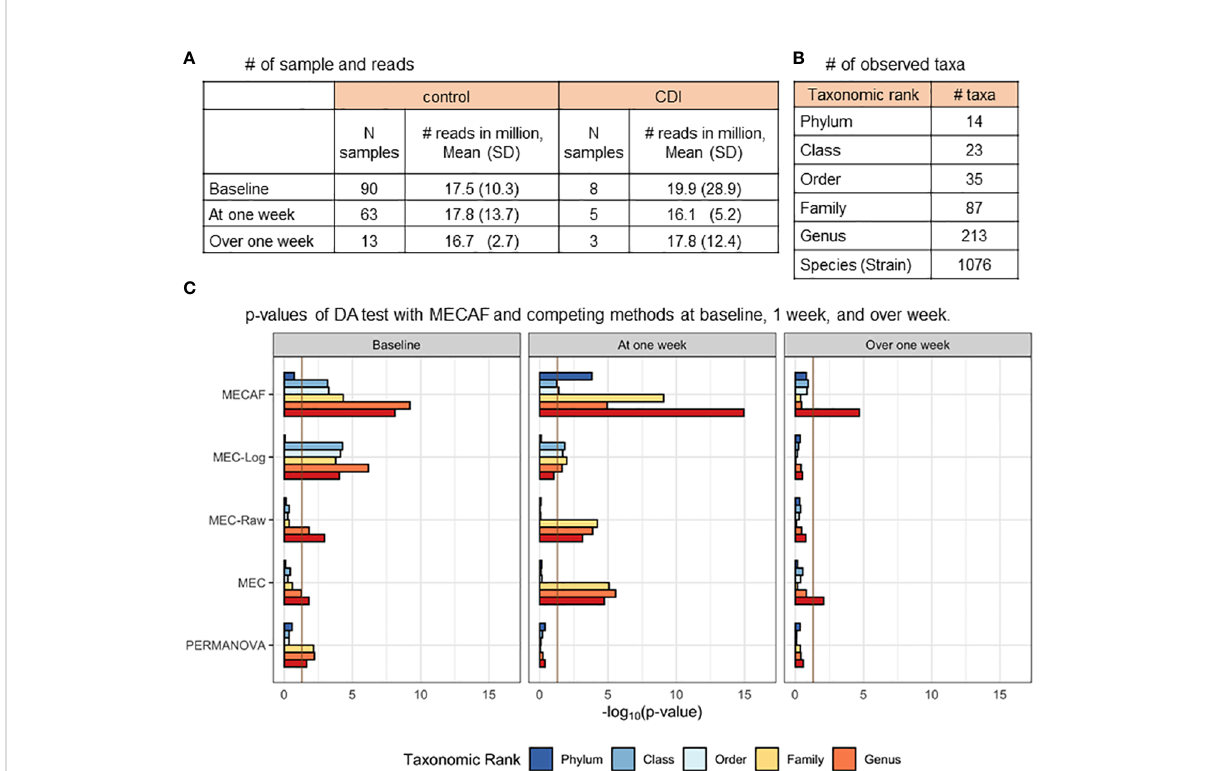
FIGURE 4 DA analysis of the CDI metagenomic dataset. (A) The number of samples and microbial reads are summarized. (B) Number of observed taxa at each of the taxonomic ranks. (C) p-Values of DA test with MECAF and competing methods at baseline, 1 week, and over 1 week. p-Values were fi cance where the vertical line of -log – log 10 transformed to better illustrate the statistical signi 10 0.05 indicates a p-value equal to 0.05. DA, differential abundance; CDI, Clostridium dif fi cile